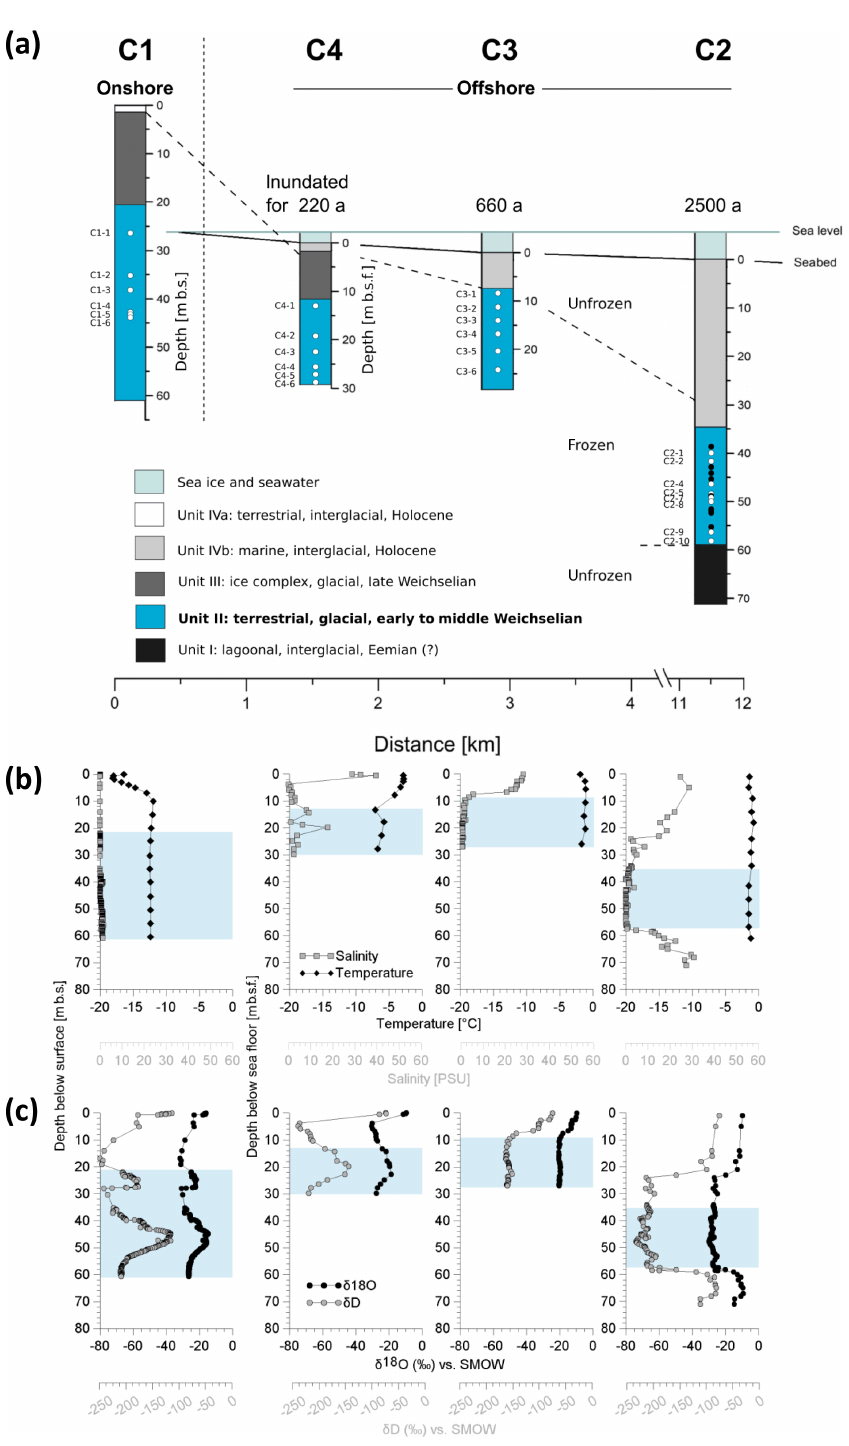
Figure 2. Overview of the coring transect with the position and characteristics of the terrestrial and submarine sediment cores. (a) Periods of inundation are indicated above each submarine core. The core depth of the terrestrial core is given in metres below the surface (mb.s.) and the depth of the submarine cores in metres below the seafloor (mb.s.f.). The core depths are proportional to each other, whereas the distance scale is only schematic. Affiliation of sediment deposits to discrete sediment units (Unit I–IVb), accumulated under similar environmental conditions in the same glacial or interglacial period, are distinguished by colours. Dots show the depth of the molecular samples. White dots represent samples from this study. Their denomination is indicated to the left. Black dots represent samples from a previous study. (b) Depth profiles of temperature (black diamonds) and salinity (grey squares) as well as of (c) the pore water stable isotopes δ 18 O (black circles) and δ D (grey circles) from the cores C1, C4, C3, and C2. The blue shaded area represents Unit